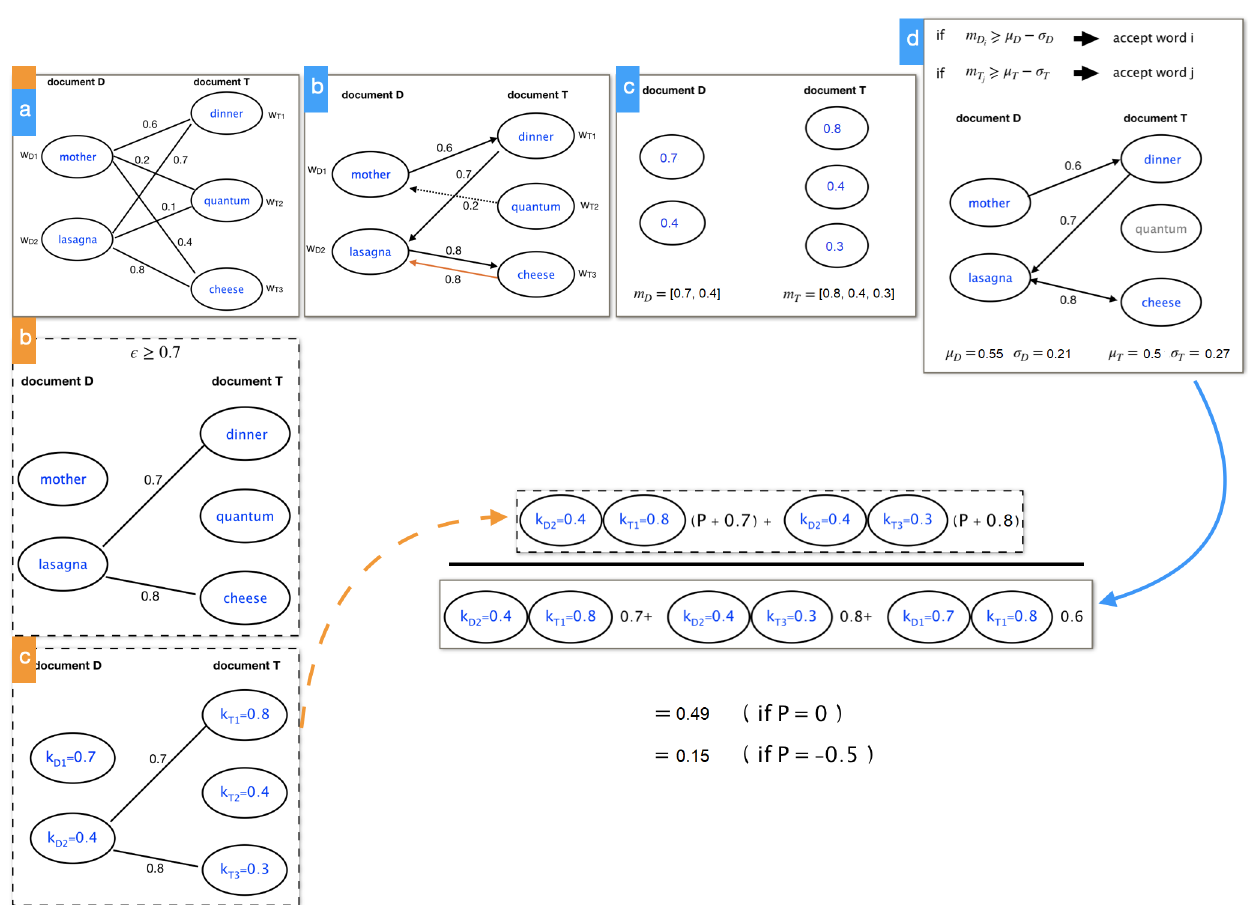
Figure A1. Illustrative representation of the GTSM algorithm. It is assumed that we already performed vectorization of words at this stage, obtained weights, and calculated similarities between words. Orange dashed line (denominator): ( a ) relations between all words in two documents, ( b ) set up a threshold (cid:101) and ignore all relations that are less than (cid:101) , ( c ) consider weights of words. Then multiply similarities to the corresponding weights of words. Blue solid line (numerator): ( a ) relations between all words in two documents, ( b ) leave only those similarities that are maximum in respect to each word where dashed line denotes to ignore the link and orange line to consider that there is a repeated relation, ( c ) record them in lists m D and m T , ( d ) calculate mean and standard deviation for each list, estimate values of which words are out 1 σ and ignore those words and their relations. We note, that in case (cid:101) is selected such that the majority of relations between w D and w T are included (e.g., (cid:101) = 0.1), then GTSM algorithm 1 1 takes into account even non-essential word relations. The evaluated similarity score can be greater than one. In order to normalize the obtained value to (0, 1)-range, it is possible to use elementary mapping, such as f ( s ) = 1 − exp ( − s ) . However, since obtained similarity score is used in k -NN (or other evaluation methods) and only relative values matter(i.e., whether two documents are more similar than the others), such normalization can be omitted. From this example it is clear that (cid:101) parameter (as well as P parameter) of the GTSM can be used as rigging parameters for specific problem